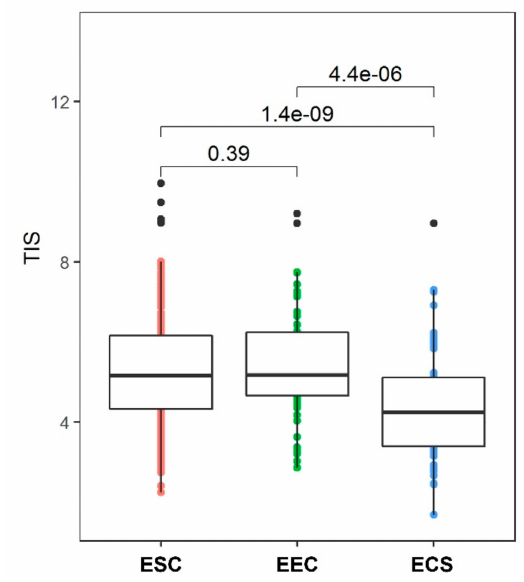
Figure 4. A boxplot histogram of Tumor Inflammation Signature (TIS) scores by endometrial cancer type in endometrial carcinosarcoma (ECS), endometrial serous carcinoma (ESC), and endometrial endometrioid carcinoma (EEC). p values from analysis of variance (ANOVA) test are shown for all